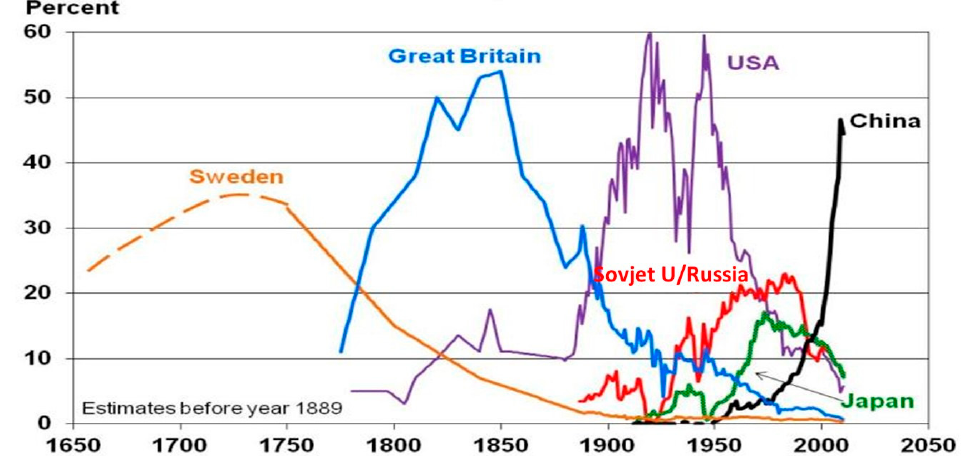
Figure 3. World steel production, historical data from [3].